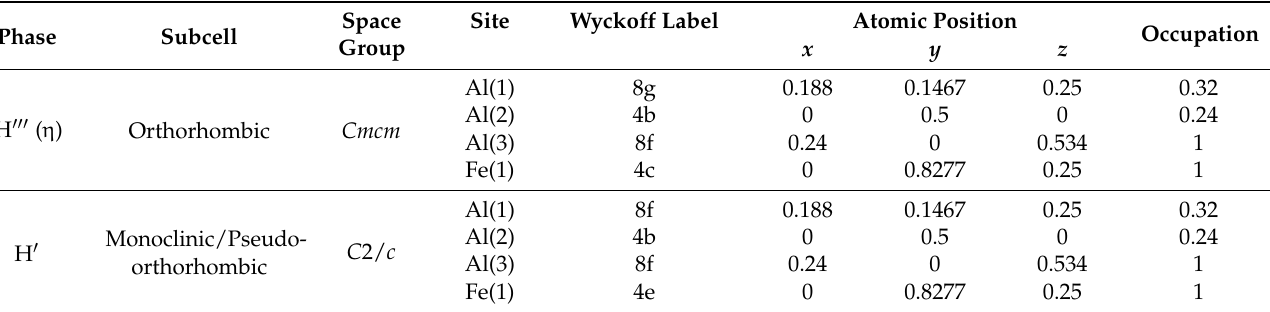
Table A1. Structure models of the pseudo-orthorhombic η (cid:48) and orthorhombic η (cid:48)(cid:48)(cid:48) / η phase as used for indexing of EBSD patterns. Atomic positions are adopted from the crystal structure model of the disordered η -Al 5 Fe 2 by Burkhardt [33] and were used for both phases to receive reflectors in the same order with similar intensities for